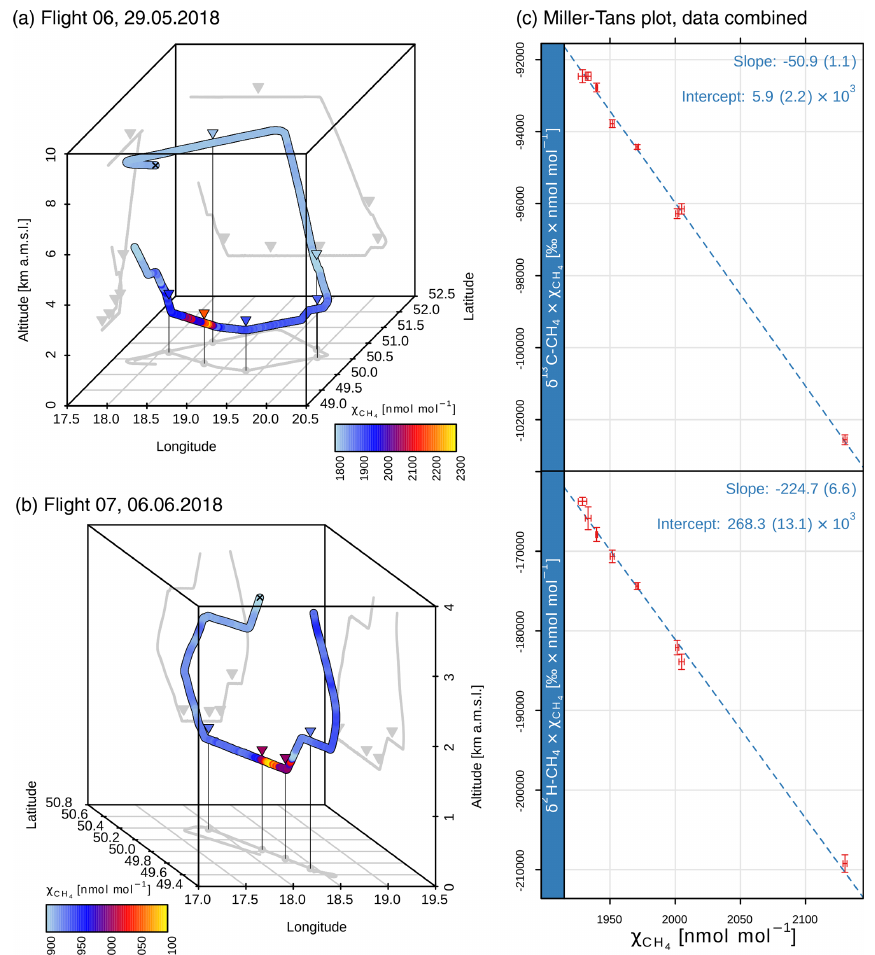
Figure 8. (a, b) Visualisation of CH 4 measurements over USCB during flights no. 6 (a) and no. 7 (b) . For flight no. 7, only data from below 4km altitude are plotted for clarity. Coloured lines represent mole fractions along the flight path, with the first plotted measurement marked with “x”, and triangles show the flask sampling locations. Both in situ and flask mole fractions are coloured using the same scale. (c) Miller– Tans model of isotopic source signatures for δ 2 H and δ 13 C, based on eight flask samples collected below 3km over the USCB during flight nos. 6 and 7 together. See text description for details. The dashed line is the linear fit using the Williamson–York formula (Cantrell, 2008). Values of fit parameters are given with 1 σ uncertainty in the parentheses.